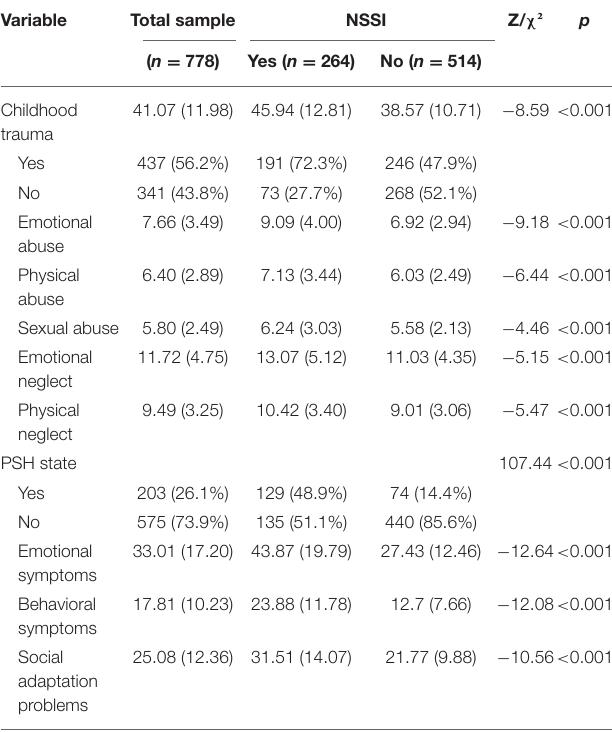
TABLE 2 | The prevalence and intergroup comparison of childhood trauma and psychological sub-health state.